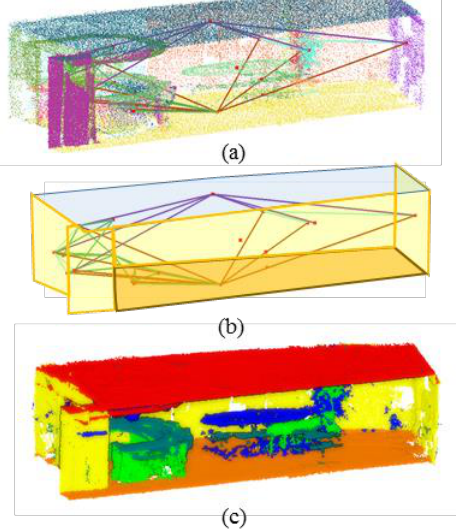
Figure 1: (a) shows the segmented point clouds and the adjacency graph. (b) The adjacency graph and (c) detected walls in yellow, floor in orange and ceiling in red colour. Other colours represent the clutter (e.g. furniture).